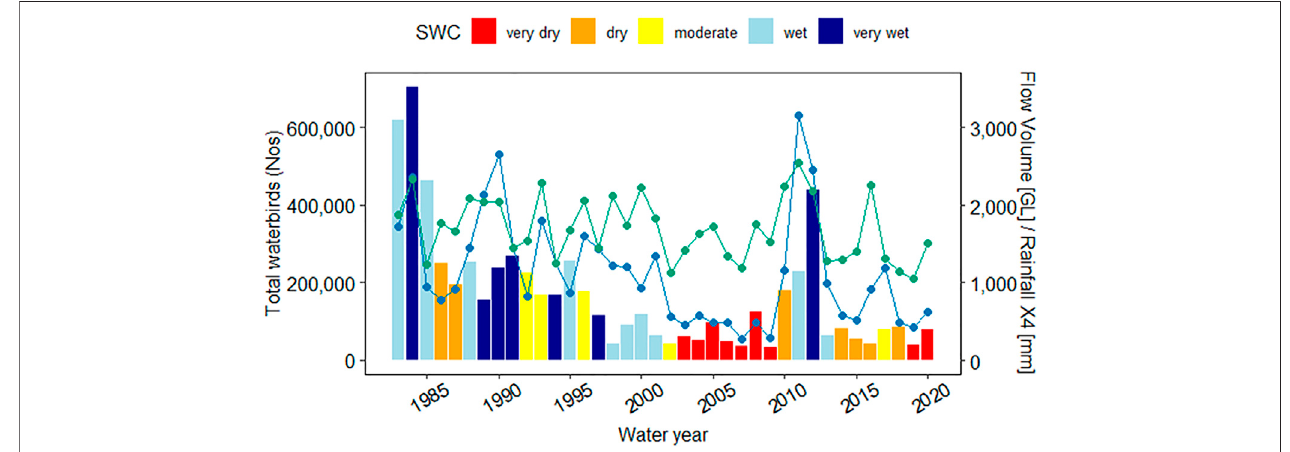
FIGURE 2 | Annual (1983 – 2020) waterbird abundance (columns, coloured by SWC) and average fl ow volume (blue line and points) and rainfall (green line and points) across the Murray – Darling Basin ( Supplementary Appendix S2 for gauge information).